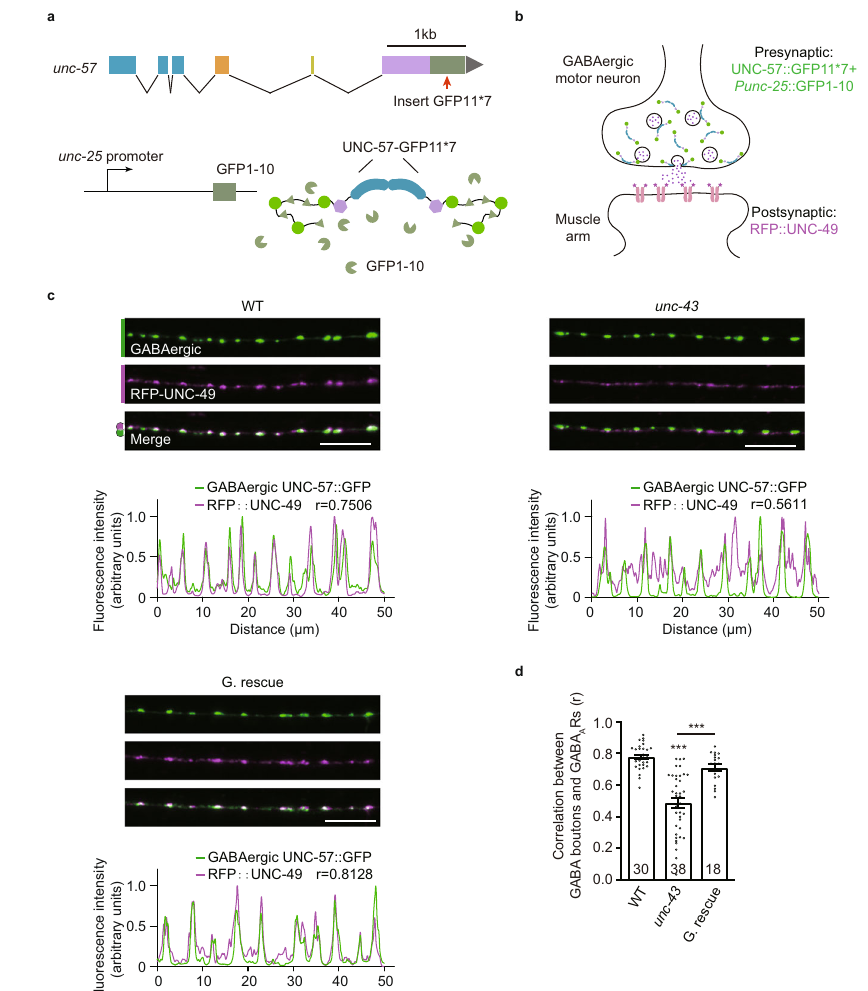
Fig. 2 | Presynaptic UNC-43/CaMKII is required for the GABAergic synaptic localization of GABA A Rs. a , b Schematic illustration of labeling UNC-57 at the GABAergic motor neurons by split GFP complementary system. Seven copies of the split GFP11 were inserted into the C-terminal of unc-57 genomic loci by CRISPR-Cas9 system. The split GFP1-10 was expressed in GABAergic motor neu- rons by unc-25 promoters. c , d The colocalization coef fi cient between GABA A Rs and GABAergic synaptic boutons was decreased in the unc-43 mutants; this was rescued by transgenic expression of UNC-43 in GABAergic motor neurons (G.